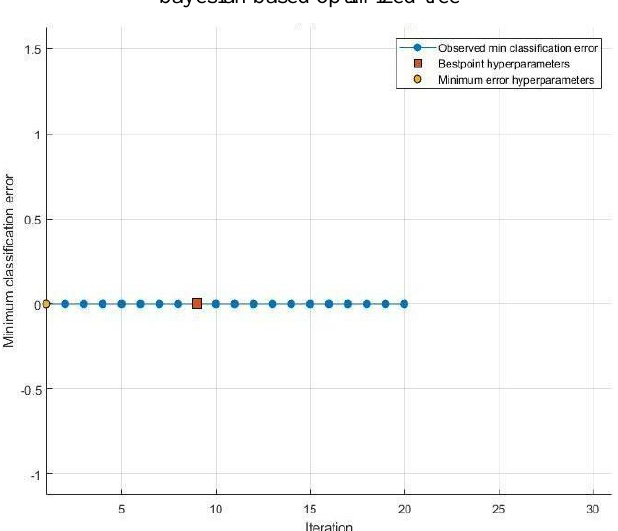
Fig. 24. SYN DOS minimum classification error of bayesian based optimized tree